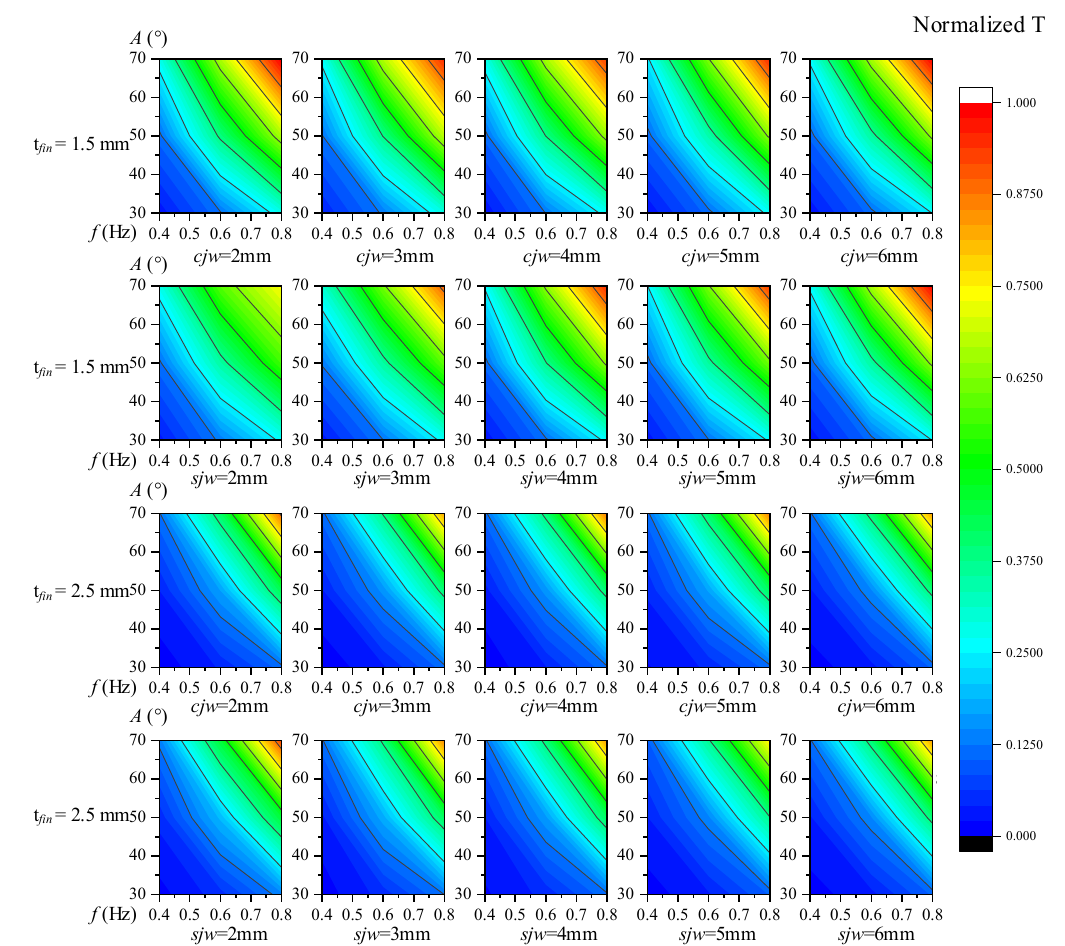
Figure 5. Isobars of normalized T for different widths of CJFs with different motion parameters. The Normalized T isoplot shows that the 2.5 mm thick CJF has a bluer area at low motion parameters than the 1.5 mm thick CJF. This phenomenon is due to the bionic